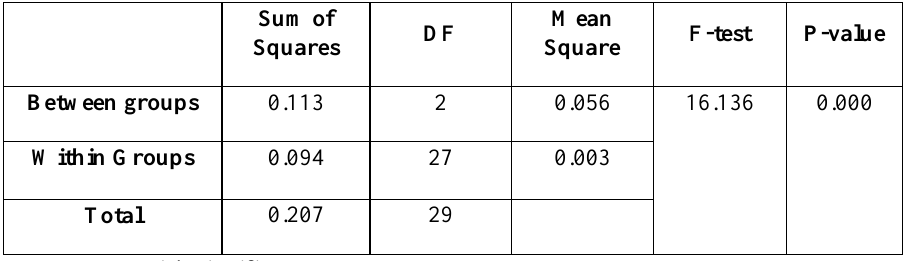
Table 3: LSD test between the groups of different surface treatment. Mean Difference P-value Sig Group I (control) & Group II (AL 2 O 3 ) 0.071 0.012 S * Group I (control) & Group III (CO 2 Laser ) 0.079 0.006 HS ** Group II (AL 2 O 3 ) & Group III (CO 2 Laser )